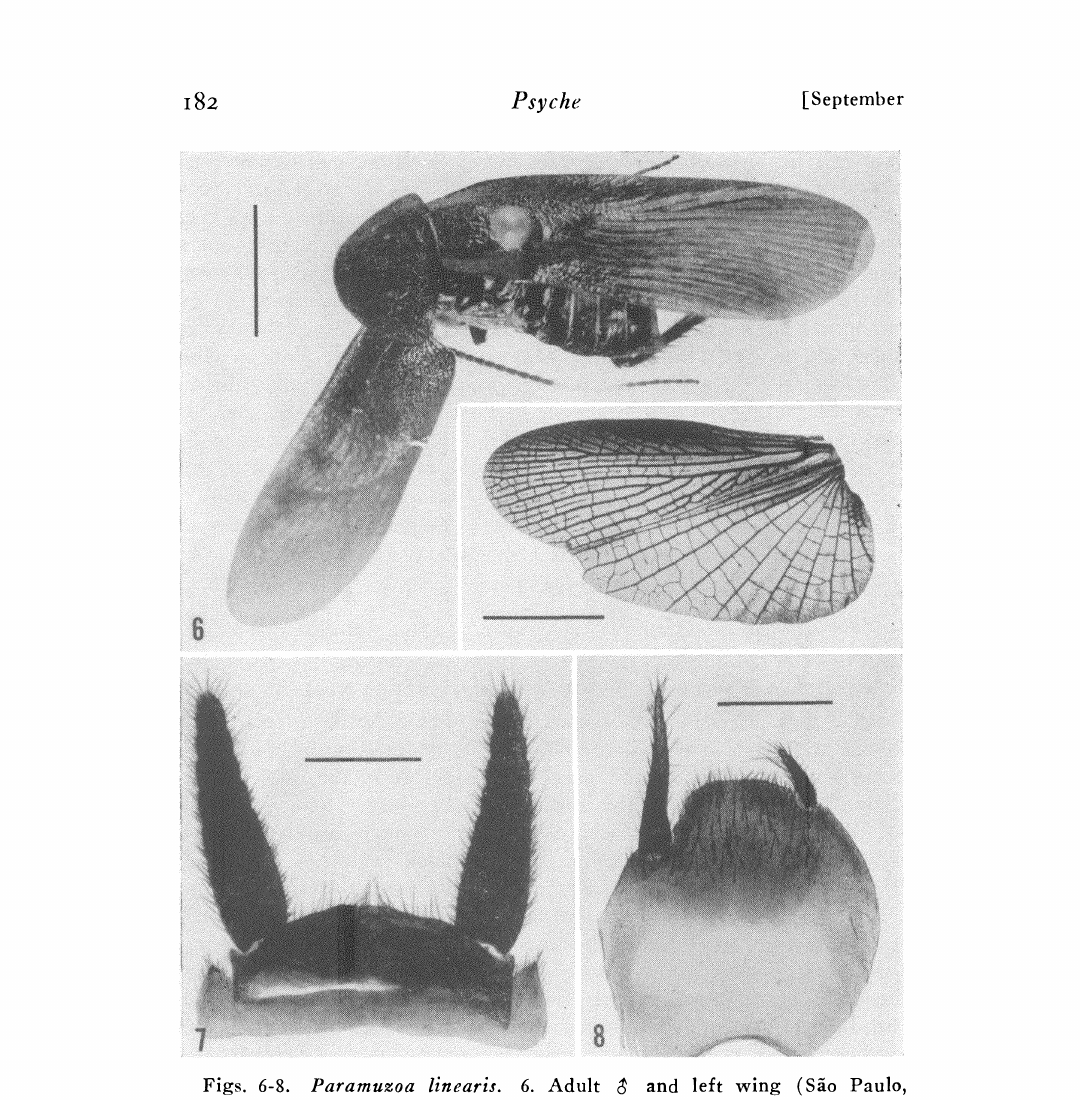
Figs. 6-8. Paramuzoa linearis. 6. Adult 8 and left wing (So Paulo, Cipo, Brazil, 25-XI-1967, leg. V. N. Alin, U.S. National Museum; det. Gurney). 7. Supra-anal plate and eerei (dorsal). 8. Subgenital plate and styles (ventral). (Figs. 7 and 8 KOH preparations from specimen shown in Fig. 6; scale: fig. 6 mm, figs. 7-8----1